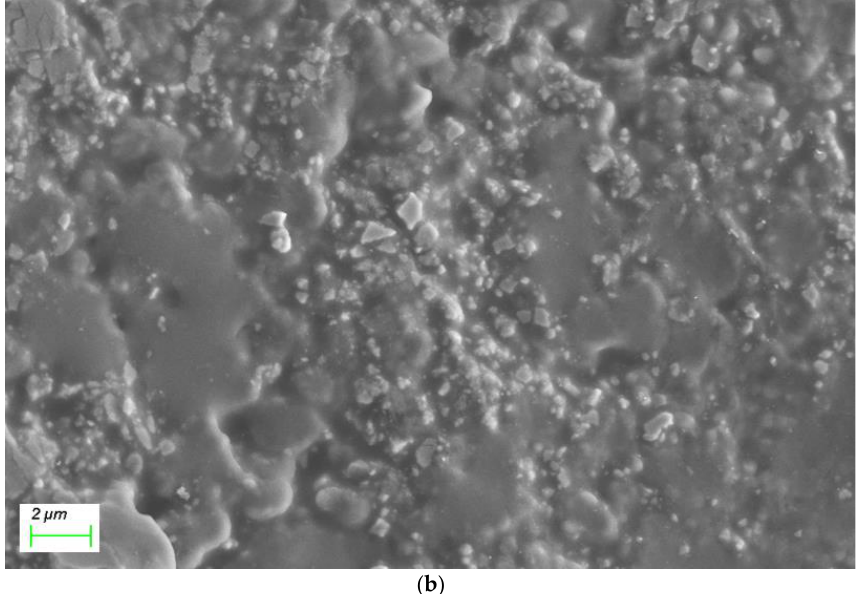
Figure 2. SEM images of the carbon film coating. ( a ) The Ni wire with carbon film coating viewed at 97× magnification, ( b ) the carbon film viewed at 4000× magnification.